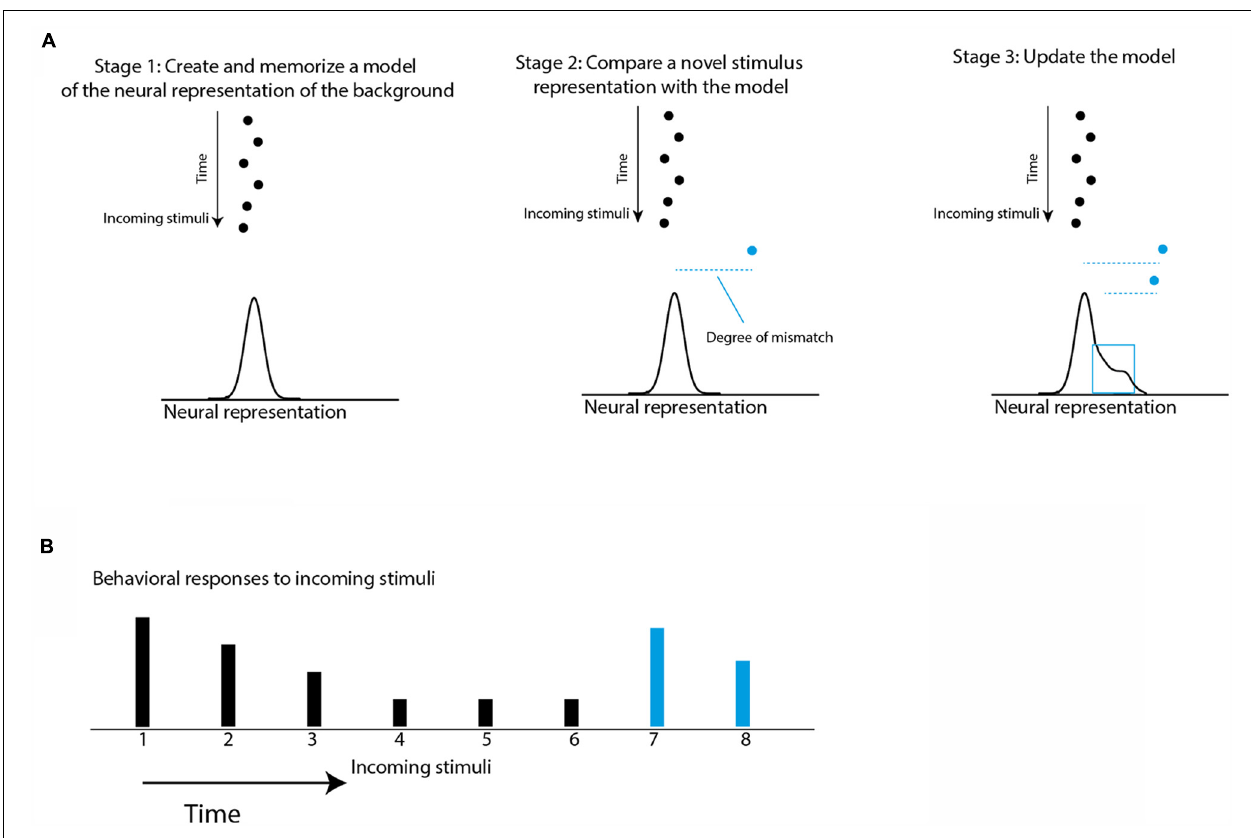
expectation violation of the new stimulus is measured based on the degree of mismatch between the internal representation of the new stimulus and the memorized model (dashed blue line). Then, in Stage 3 the representation of the new stimulus is incorporated into the model to affect the degree of mismatch of further incoming stimuli. (B) The height of the bars represents the predicted behavioral responses to the incoming stimuli (dots in A ) based on the assumption that each response is proportional to the degree of